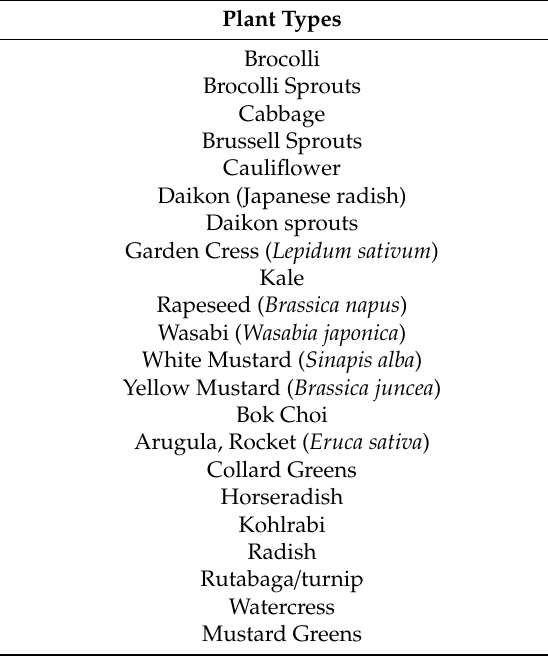
Table 1. Examples of Glucosinolate rich Cruciferous plants of the Brassicacea family order